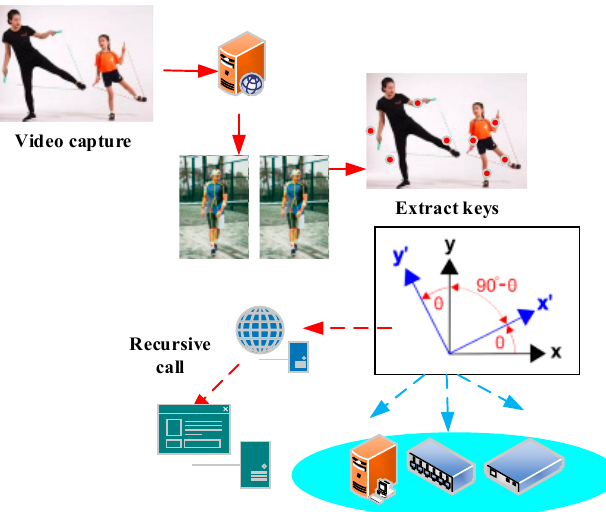
Figure 6. Human motion recognition process in the video.